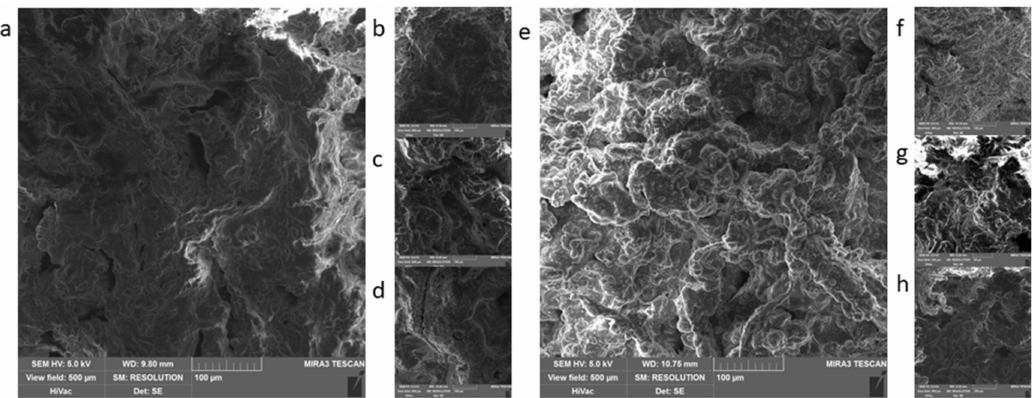
Figure 2. Non-heat treated meat products: ( a , b )—ˇcajovka, procedure 1; ( c , d )—m é tsk ý salami, procedure 1; ( e , f )—ˇcajovka, procedure 2; ( g , h )—m é tsk ý salami, procedure 2.